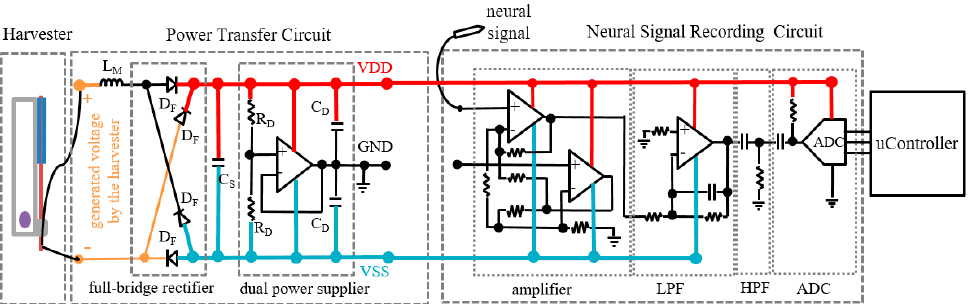
Figure 2. Power transfer circuits and neural signal recording circuits.